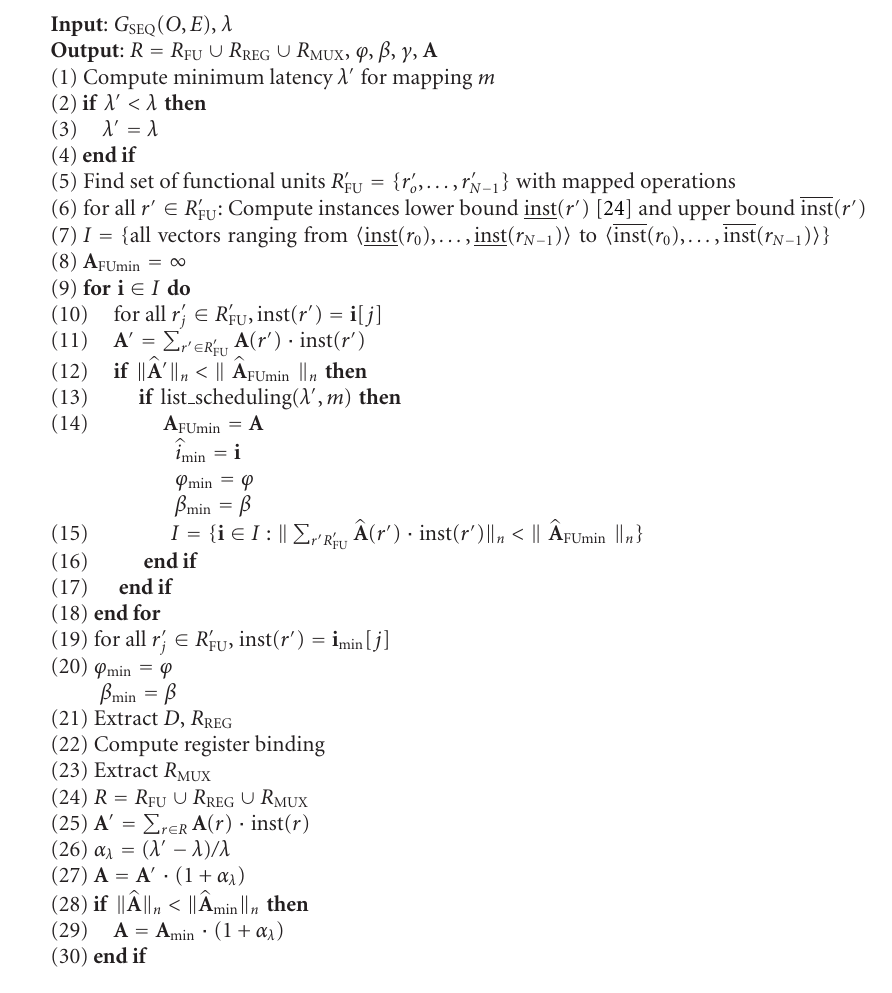
Algorithm 2: Computation of area